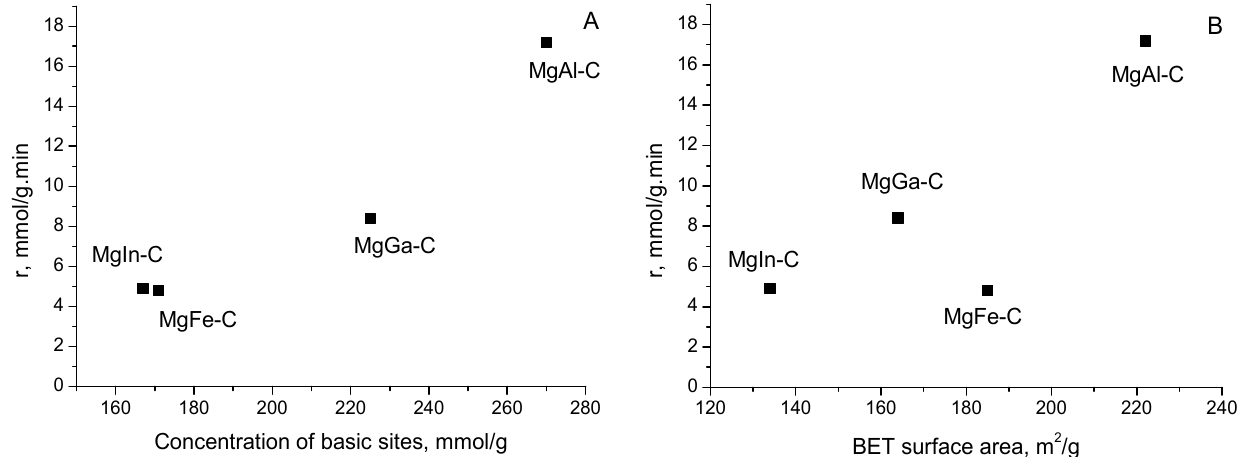
Figure 4. The dependence of the initial reaction rate on the concentration of basic sites ( A ) and BET surface area ( B ) of MgM-C samples.